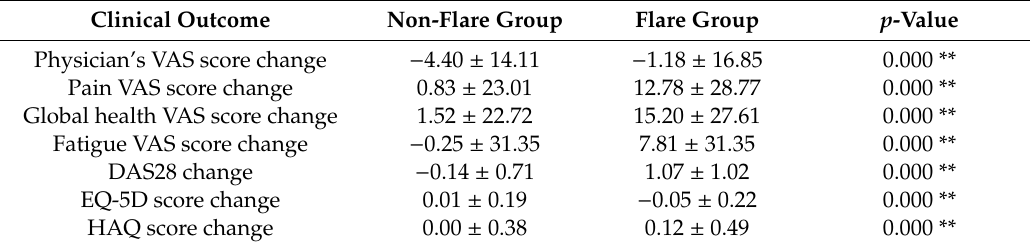
Table 3. Changes from baseline levels for 2-year clinical outcomes in non-flare and flare groups. Clinical